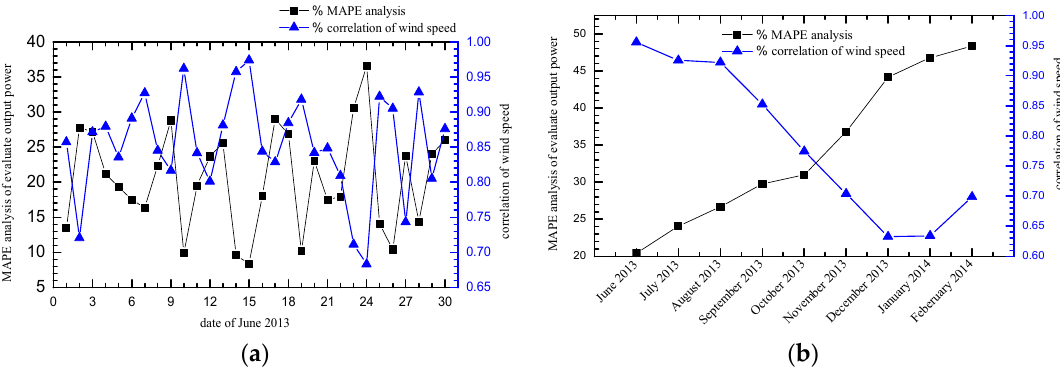
Figure 12. WSC coefficient and equivalent power error at different time scales; ( a ) Equivalent error at daily time scale; ( b ) Equivalent error at monthly time scale.